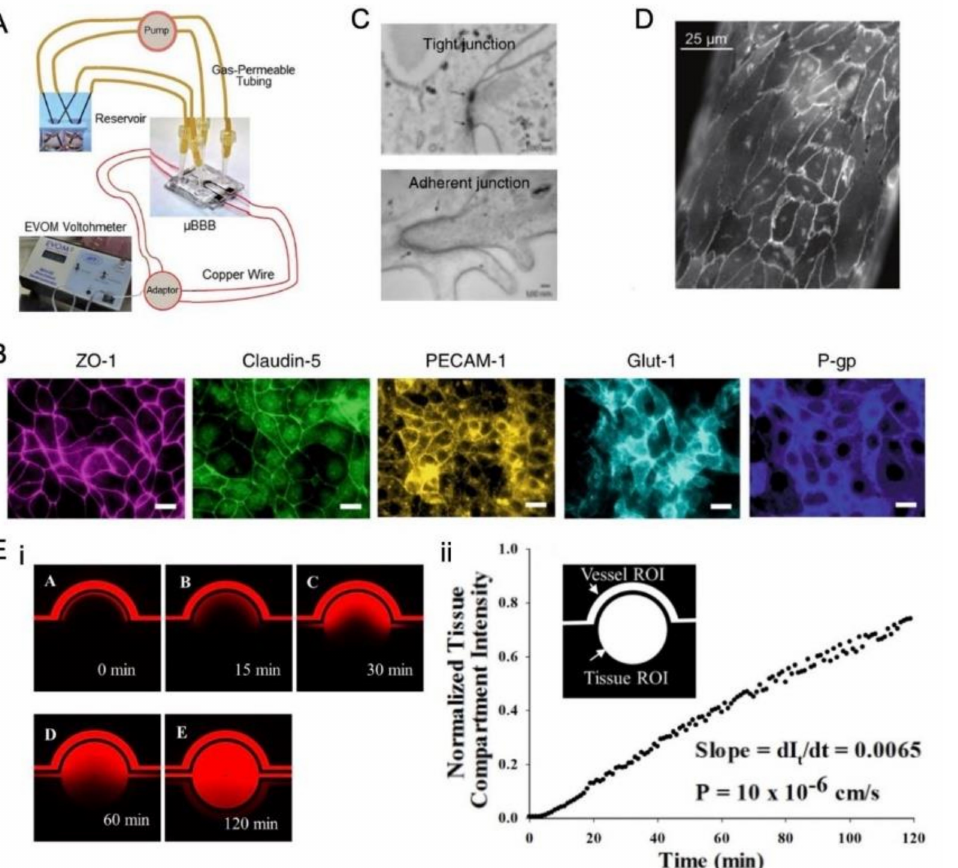
Figure 5. Different means to evaluate the BBB integrity. ( A ) TEER measurement in a BOC de- vice, where copper electrode wiring is connected to the voltohmmeter via an electrode adapter [4]. ( B ) Immunofluorescence micrographs of the human brain endothelium cultured on-chip for 3 days, showing high expression levels of ZO-1, claudin-5, PECAM-1, GLUT-1, and P-glycoprotein (bar, 20 µ m) [65]. ( C ) Electron micrograph of human brain microvascular endothelium after 3 days of culture in the BBB chip. The presence of well-formed tight junctions (top, pointed by arrows) and adherent junctions (bottom, indicated by arrows) are highlighted [65]. ( D ) Confocal fluorescence imaging of VE-cadherin for a portion of the endothelium after US exposure with the presence of MBs [21]. ( E-i ) Permeability of Texas Red dextran (40 kDa) from the vascular channel to the tissue compartment in the cell-free BOC after 5 min, 15 min, 30 min, 60 min. and 120 min from the start of flow in the vascular channel. ( E-ii ) Quantification of the normalized intensity of the dextran in the tissue compartment as shown in ( E-i ). The intensity increased linearly with time